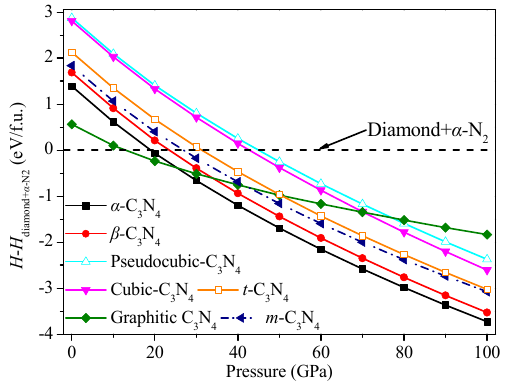
Figure 3. Calculated enthalpies of different C 3 N 4 structures relative to diamond and α -N 2 as a function of pressure.